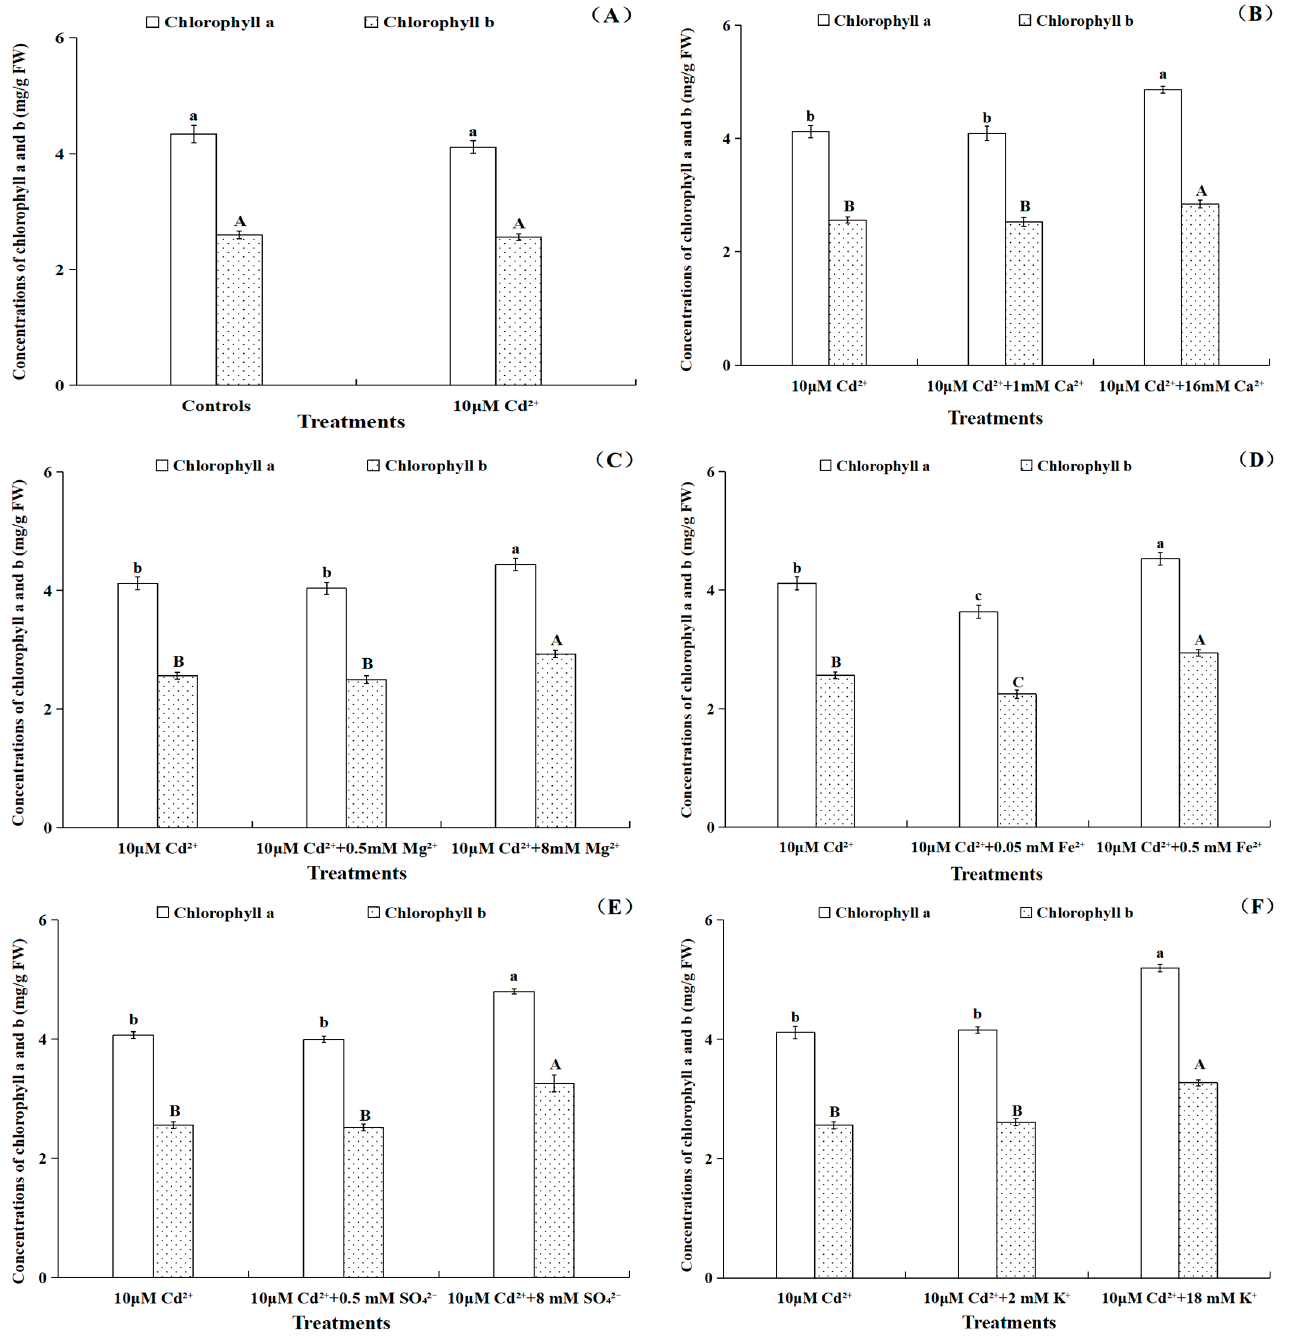
Figure 3. The concentrations of chlorophyll a and b of Bidens pilosa L. from control groups ( A ) and Cd treatment groups with different concentrations of Ca 2+ ( B ), Mg 2+ ( C ), Fe 2+ ( D ), SO 42 − ( E ) and K + ( F ). Notes: the means of chlorophyll a concentrations under different treatments marked with the same lowercase letters (a–c) were not significantly ( p > 0.05) different, and the means of chlorophyll b concentrations under different treatments marked with the same uppercase letters (A–C) were not significantly ( p > 0.05) different.